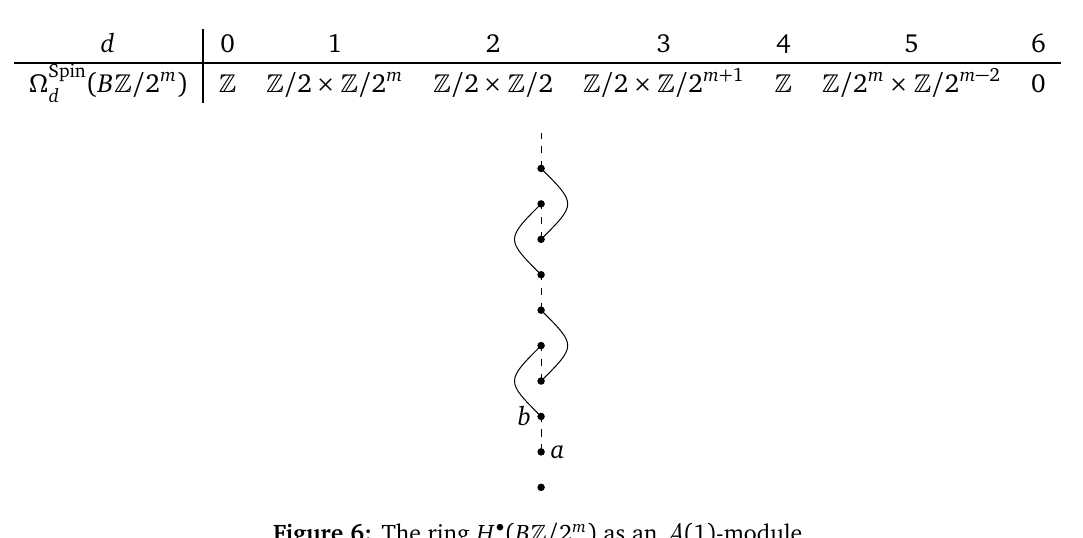
Figure 6: The ring H • ( B (cid:90) / 2 m ) as an